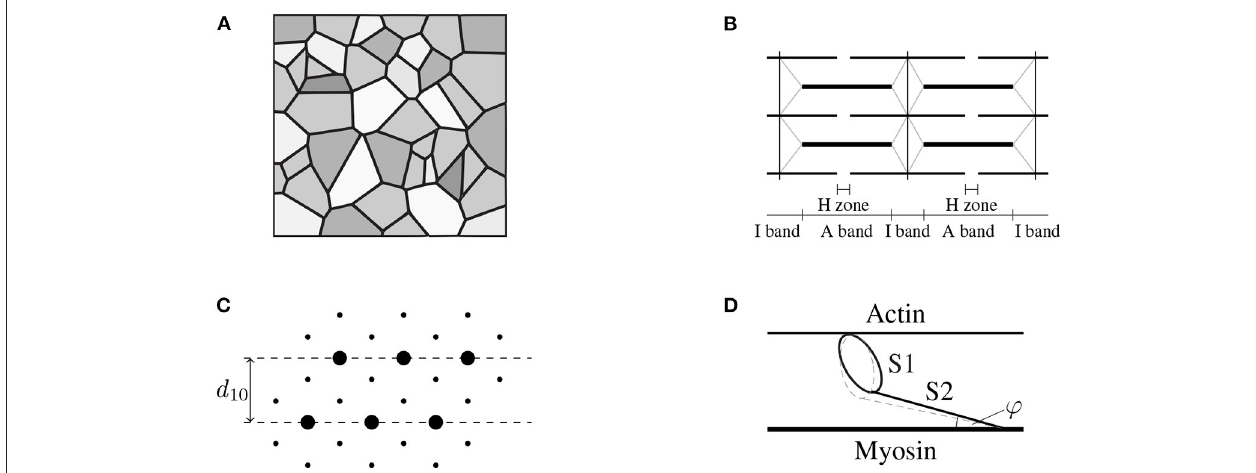
FIGURE 1 | (A) Schematic drawing of the cross-sectional area of skeletal muscle tissue (macro-scale) consisting of muscle fibers (gray), which are aligned in parallel with the extracellular connective tissue (black). Note that the intracellular and the extracellular space are separated by the muscle fiber membrane (sarcolemma). Further note that the muscle fibers, the sarcolemma and the extracellular connective tissue are mechanically interconnected through protein complexes like dystrophin. (B) The muscle fibers are constructed by a periodic filament lattice (micro-scale) consisting of the thick myosin filaments (thick black lines) and the thin actin filaments (thin black lines). The individual sarcomeres are separated by the Z-disks (illustrated by the vertical black lines). Further, the Z-disks are connected to the thick myosin filaments via the protein titin (gray lines). (C) Illustration of a cross section of the hexagonal filament lattice (micro-scale) in the overlap region of the A-Band. The thick myosin filaments are represented by big circles, the small black dots represent the thin actin filaments. The muscle fibers are orthogonal to the page. (D) Schematic drawing of a single cross-bridge (nano-scale) consisting of a catalytic domain (S1-head) and the S2 segment. The S1 head can perform a conformational change (illustrated by the dashed gray line) by the cost of ATP-hydrolysis, leading either to an extension of the S1 segment, i.e., generating stress, or leading to muscle